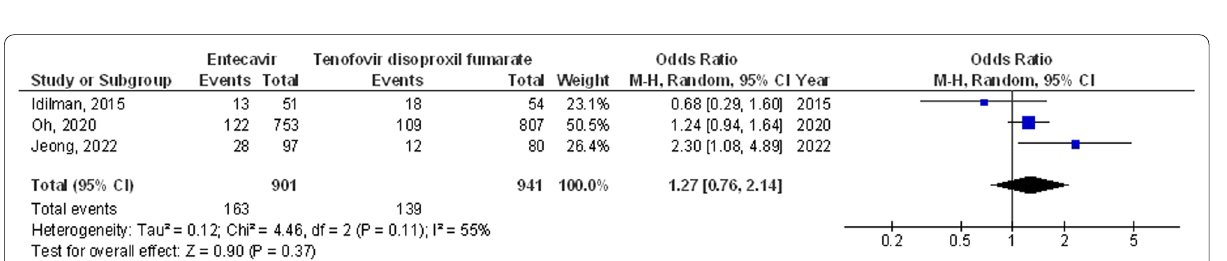
Fig. 5 Difference between the impact of entecavir and tenofovir disoproxil concerning results of seroconversion in chronic HBV